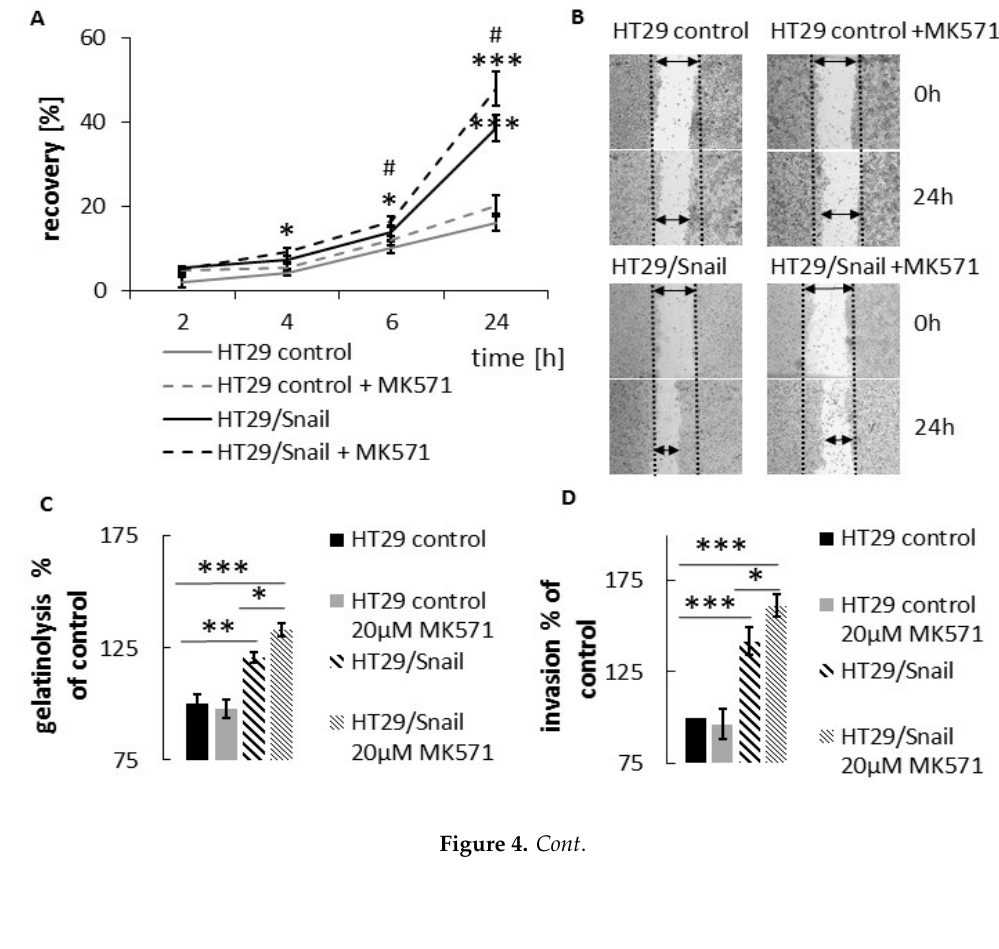
Figure 4. MK571 impact on CRC cells migratory abilities . ( A ) HT29 cells (control or overexpressing Snail) were grown to confluence on 6 well plate, next, wounded across the cell monolayer. New medium containing 20 µM MK571 was added. Wounded area was visualized after 0, 2, 4, 6 and 24 h—and presented in using Nikon Eclipse TE 2000-U microscope (Nikon, Japan) and calculated by ImageJ software [32] . Cell motility was estimated through the quantification of the % of recovery using the equation: R (%) = [1 − (wound area at Tt/wound area at T0)] × 100,where T0 is the wounded